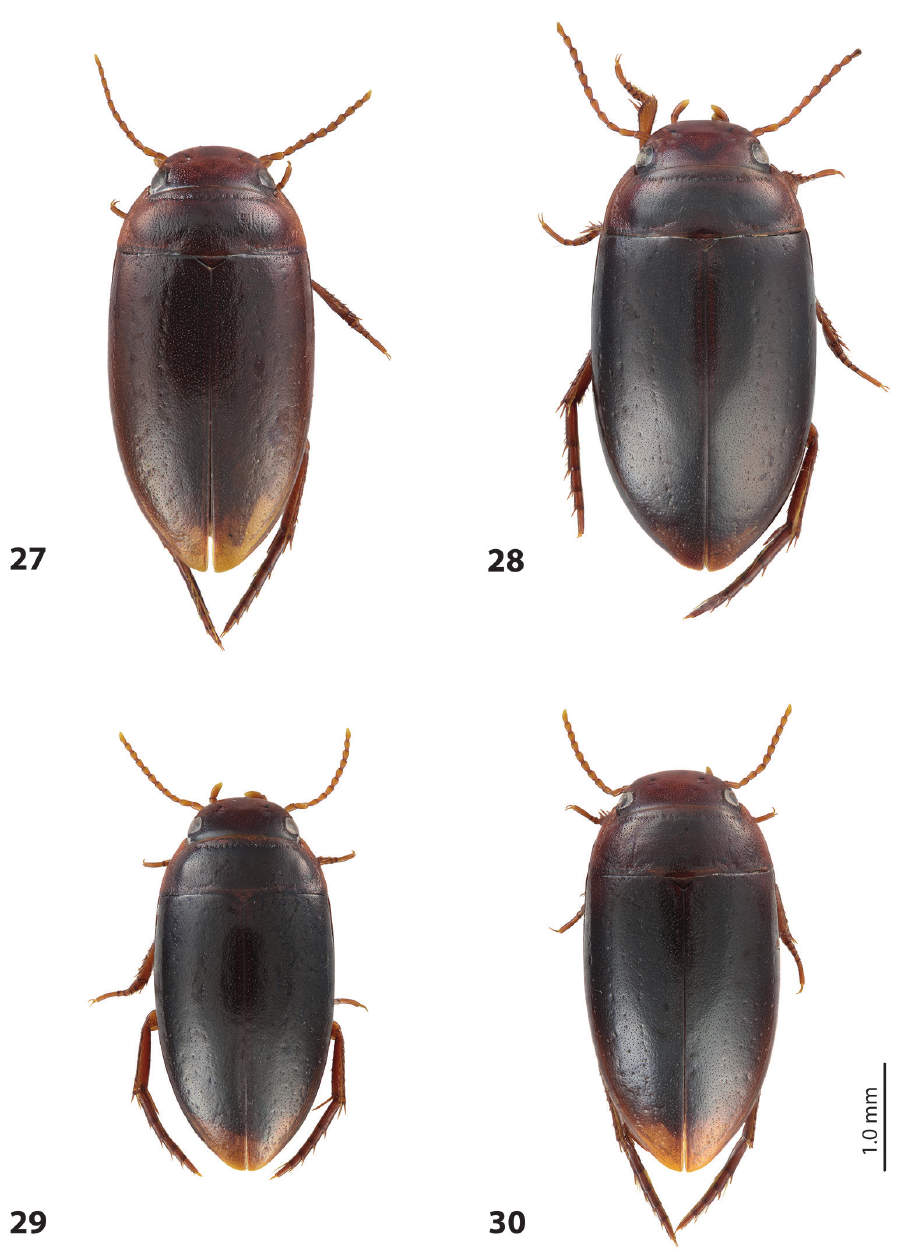
Figures 27–30. Habitus and coloration 27 Exocelina kabwumensis sp. n. 28 E. woitapensis sp. n. 29 E. andakombensis sp. n. 30 E. injiensis sp.